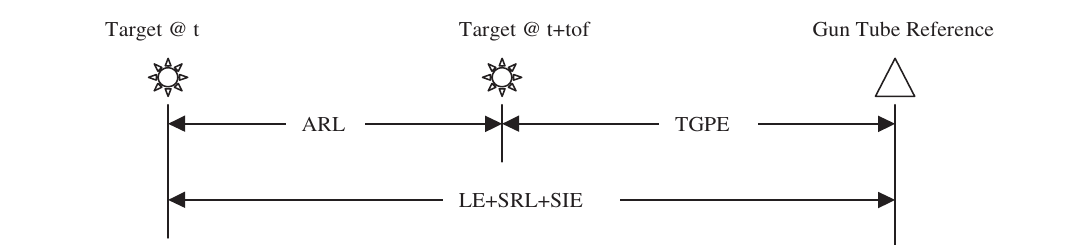
Fig. 7. CMRS azimuth and elevation time history, detail